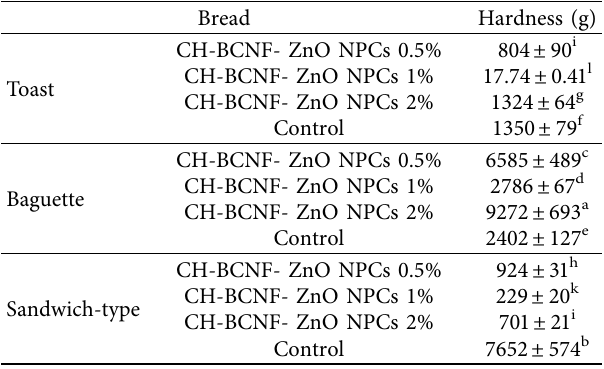
Table 4: Hardness of the diferent